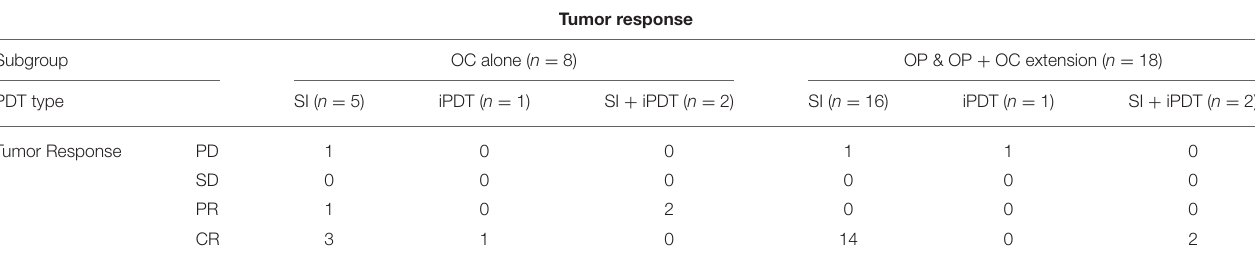
TABLE 6 | Overview of tumor response according to RECIST criteria per subgroup and per PDT modality.